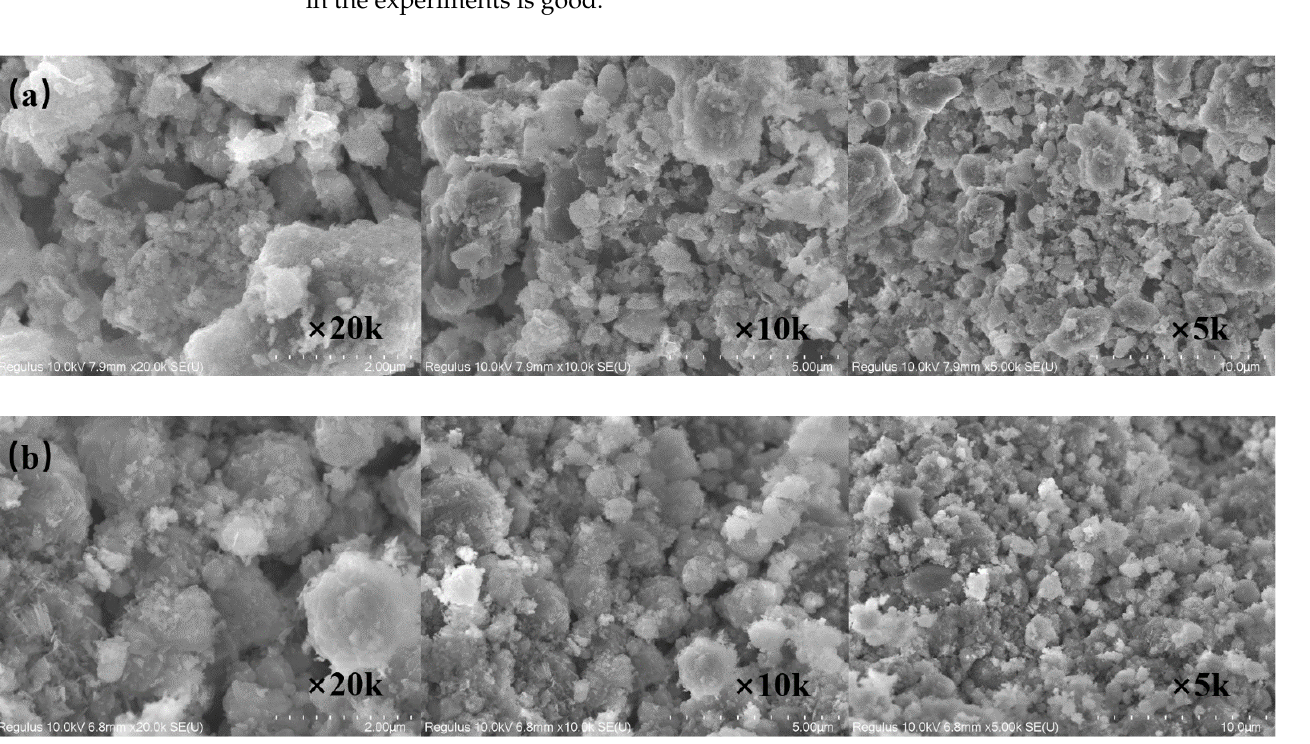
Figure 10. SEM images of the red mud: ( a ) Not used, ( b ) Used once in a combined system. (Initial CV concentration = 25 mg/L, discharge voltage = 22 kV, frequency = 50 Hz, aeration O 2 = 3.0 L/min, red mud dosage = 2.0 g, conductivity = 26 μs/cm). Table 2. BET data of the red mud before and after use in the combined system.